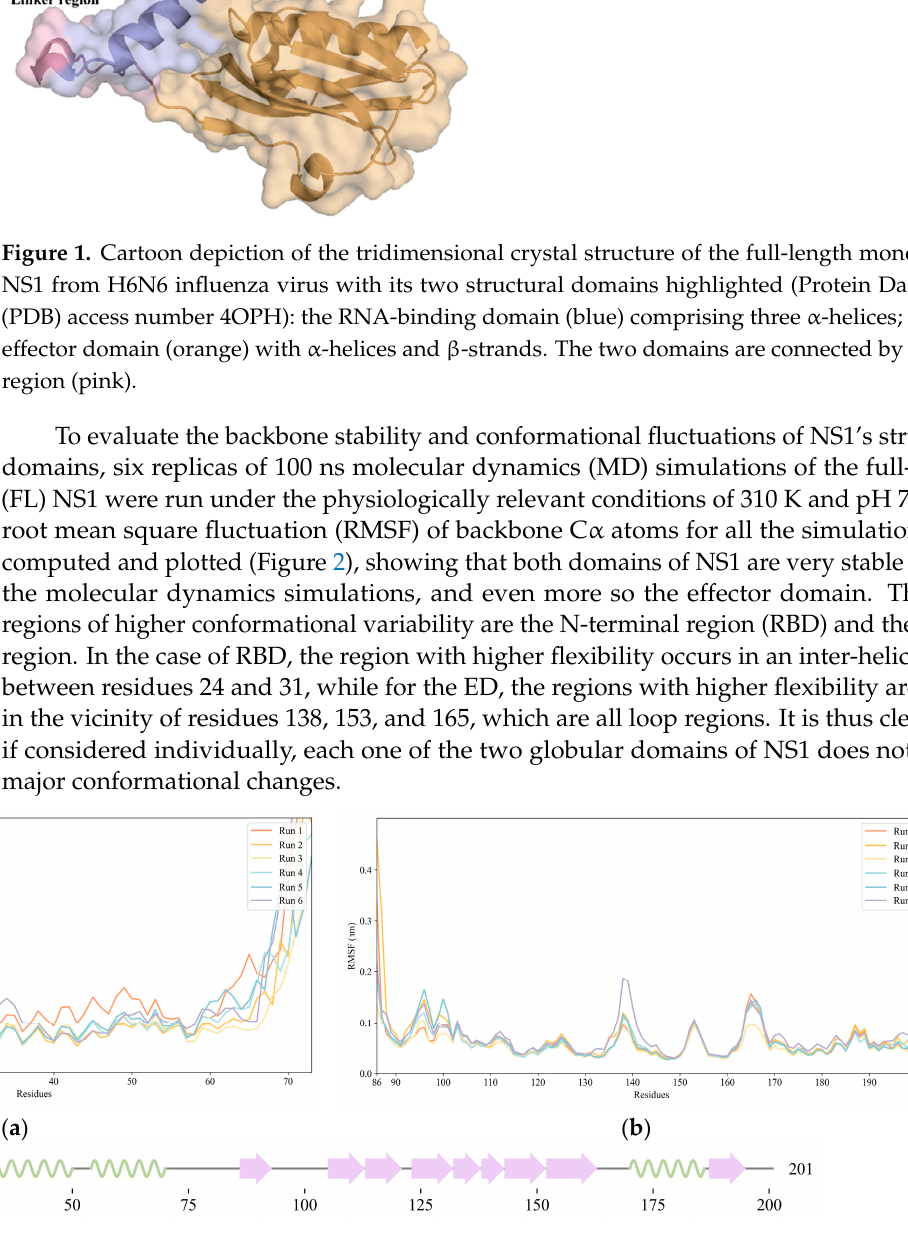
Figure 2. Root mean square fluctuation (RMSF) of NS1 C α atoms obtained from six independent molecular dynamics simulations. ( a ) RMSF of RNA-binding domain (RBD). ( b ) RMSF of effector